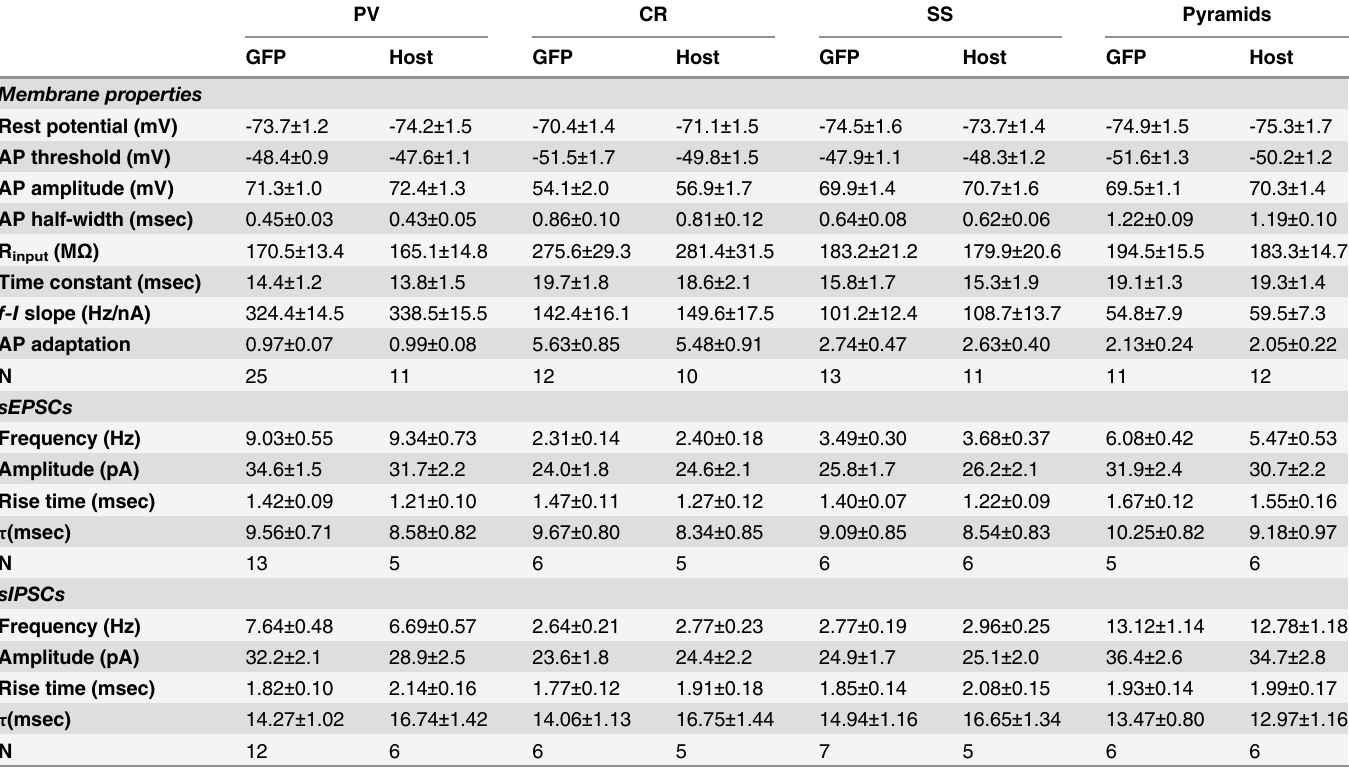
Table 1. Intrinsic membrane properties and synaptic currents of different types of neurons. PV CR